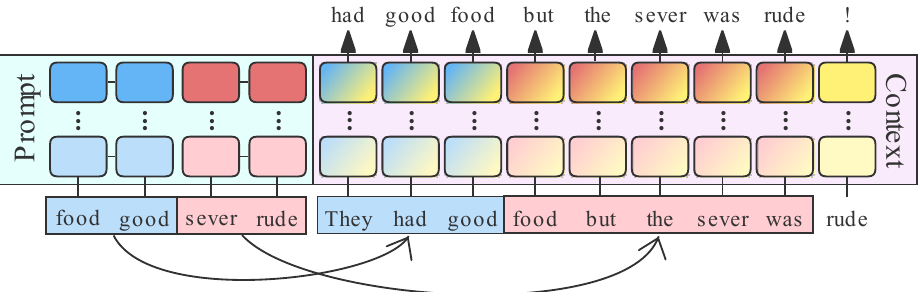
Figure 3. Illustration of how the AlSeCond model works. The curved arrow indicates where the sentiment unit should be hinted to the review sequence. The gradient color in the square indicates that this step is affected by the query-hint mechanism with prompt values brought by